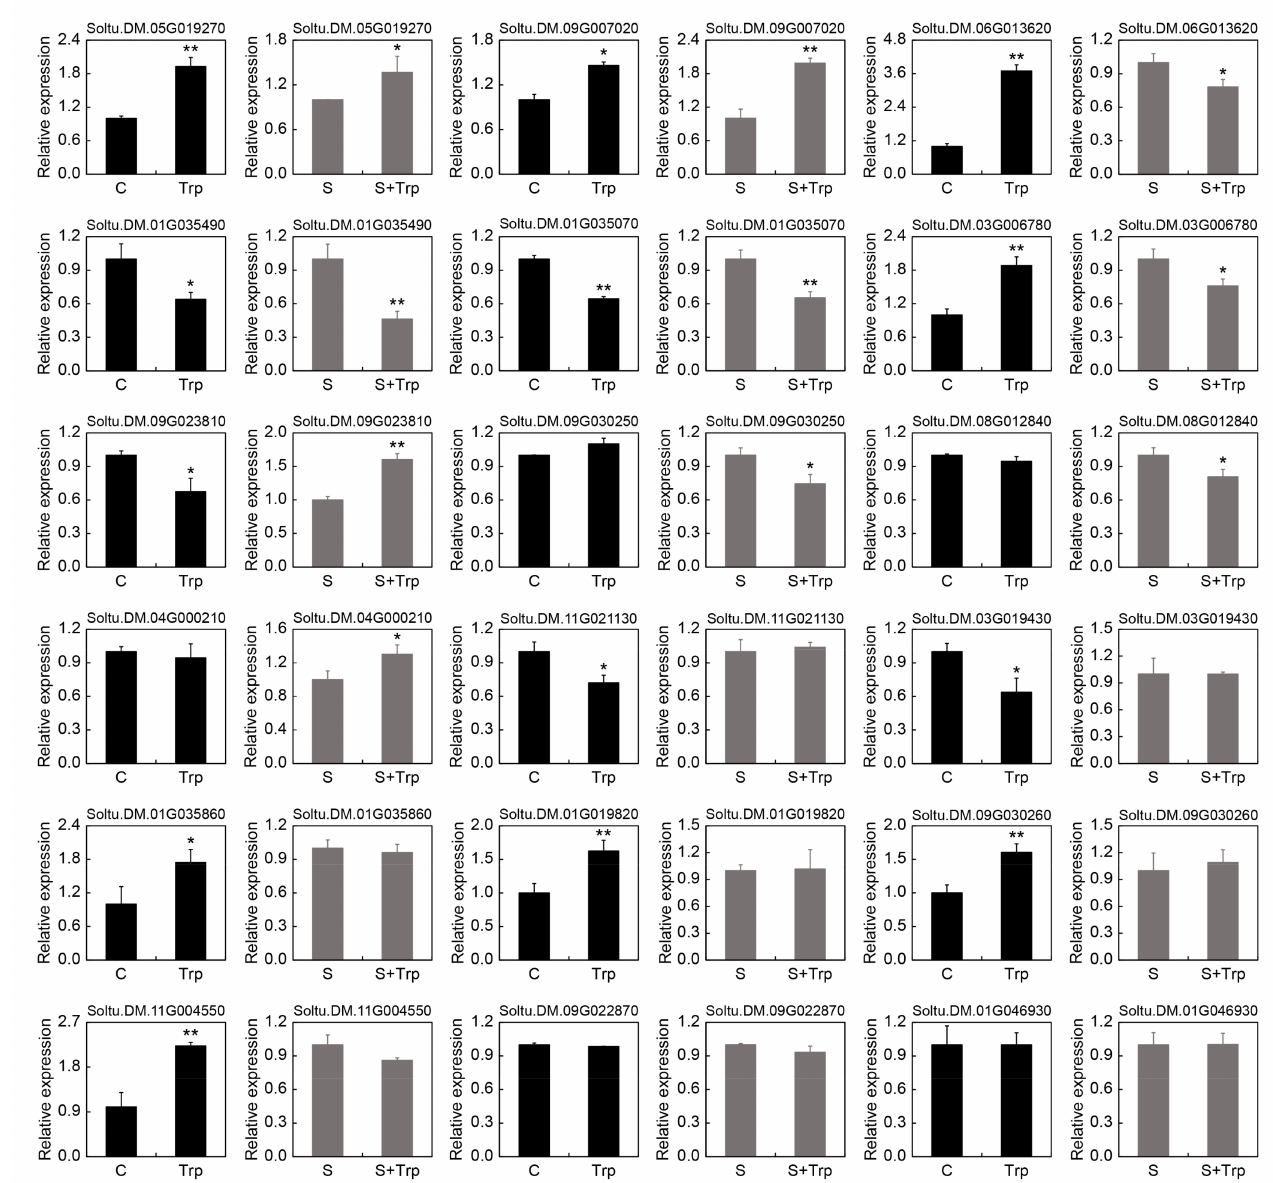
Figure 5. qRT–PCR validation of 18 DEGs. The asterisks denote statistically significant differences, as determined by Student’s t -test, * p < 0.05, ** p < 0.01. Three biological repetitions were